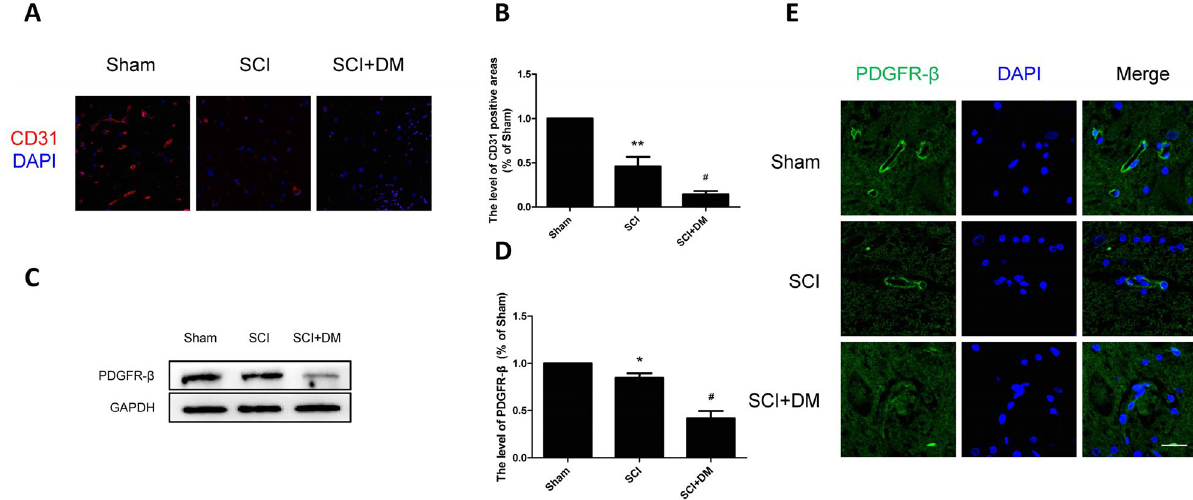
Figure 2. DM aggravates microvessels loss and decreases pericyte coverage after SCI. ( A , B ) Immunofluorescence staining of CD31 and quantification of the level of CD31 positive areas in each group, n = 4. Scale bar = 50 μm. ( C , D ) Western blot and quantification of PDGFR-β in each group, n = 6. ( E ) Immunofluorescence staining of PDGFR-β in each group, n = 4. Scale bar = 10 μm. *p < 0.05, **p < 0.01 vs sham group, # p < 0.05 vs SCI